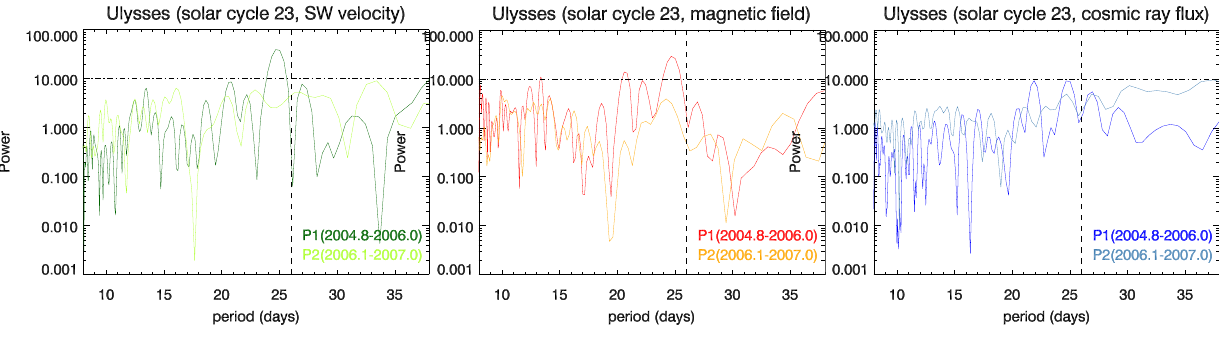
Fig. 7. Lomb periodograms for Ulysses measurements in the time interval C23 in the same representation as in Fig.